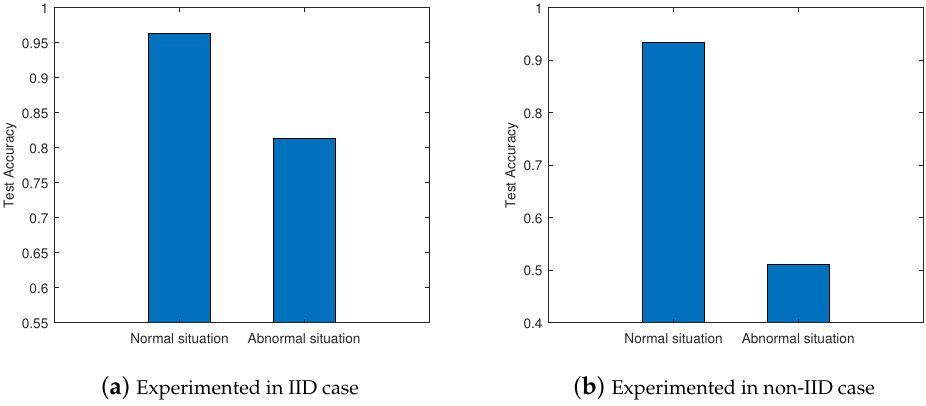
Figure 6. Accuracy comparison of FL for MNIST data set in IID and non-IID cases with clients leaving.